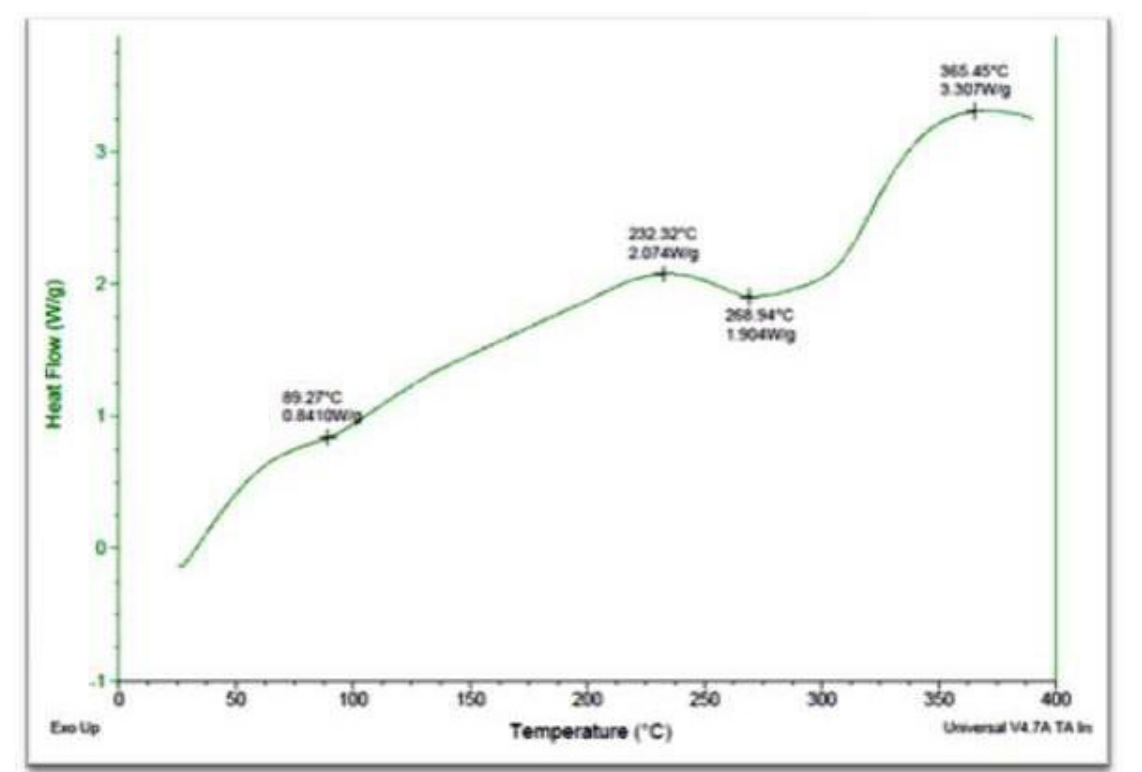
FIGURE 9 - (a) DSC of Ketoprofen at temp. 98.09 °C. (b) DSC of Physical Mixture of Batch P2p [Ketoprofen: Polo (1:1.5)] at temp. 95.68 °C. (c) DSC of Solid Dispersion of Batch P2 [Ketoprofen: Polo (1:1.5)] at temp. 52.65 °C. (d) DSC of Physical Mixture of Batch E1p [Ketoprofen: Eud (1:1)] at temp. 95.37°C. (e) DSC of Solid Dispersion of Batch E1 [Ketoprofen: Eud (1:1)] at temp. 89.27